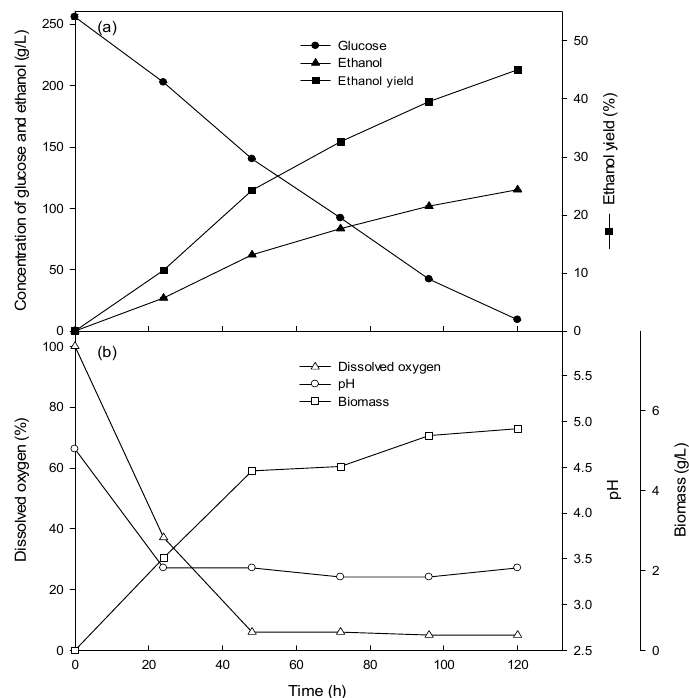
Figure 5. Time course of ( a ) glucose, ethanol concentration, and ethanol yield change, ( b ) dissolved oxygen, pH, and biomass in the batch cultures of S. cerevisiae BCRC 21812. The initial glucose concentration was 26% ( w / v ).